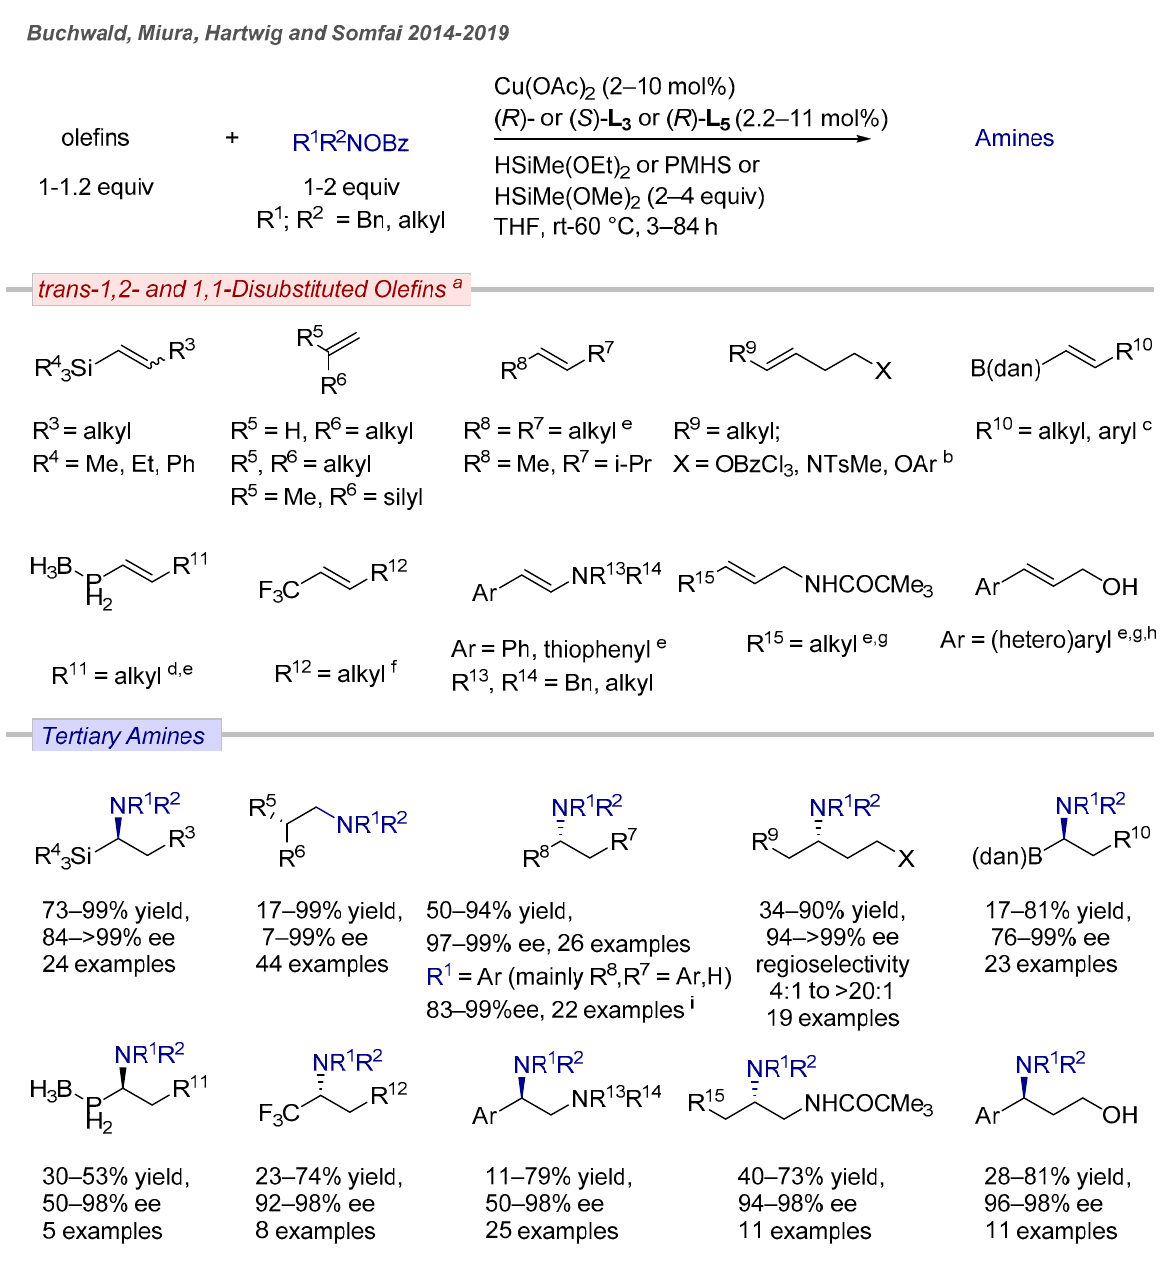
Figure 25. Regio- and enantioselective biphosphine · CuH-catalyzed hydroamination of 1,2- trans and 1,1 (cid:48) -disubstituted 25 alkene derivatives. a all reactions run with Cu(OAc) 2 , ( R ) or ( S )- L 3 , R 1 R 2 NOBz (R 1 ; R 2 = Bn, alkyl) in THF unless otherwise stated. b 10 mol% Cu(PPh 3 )H. c with LiO t Bu (4 equiv). d Cu(OAc) 2 · H 2 O (10 mol%) with LiO t Bu (3 equiv) in